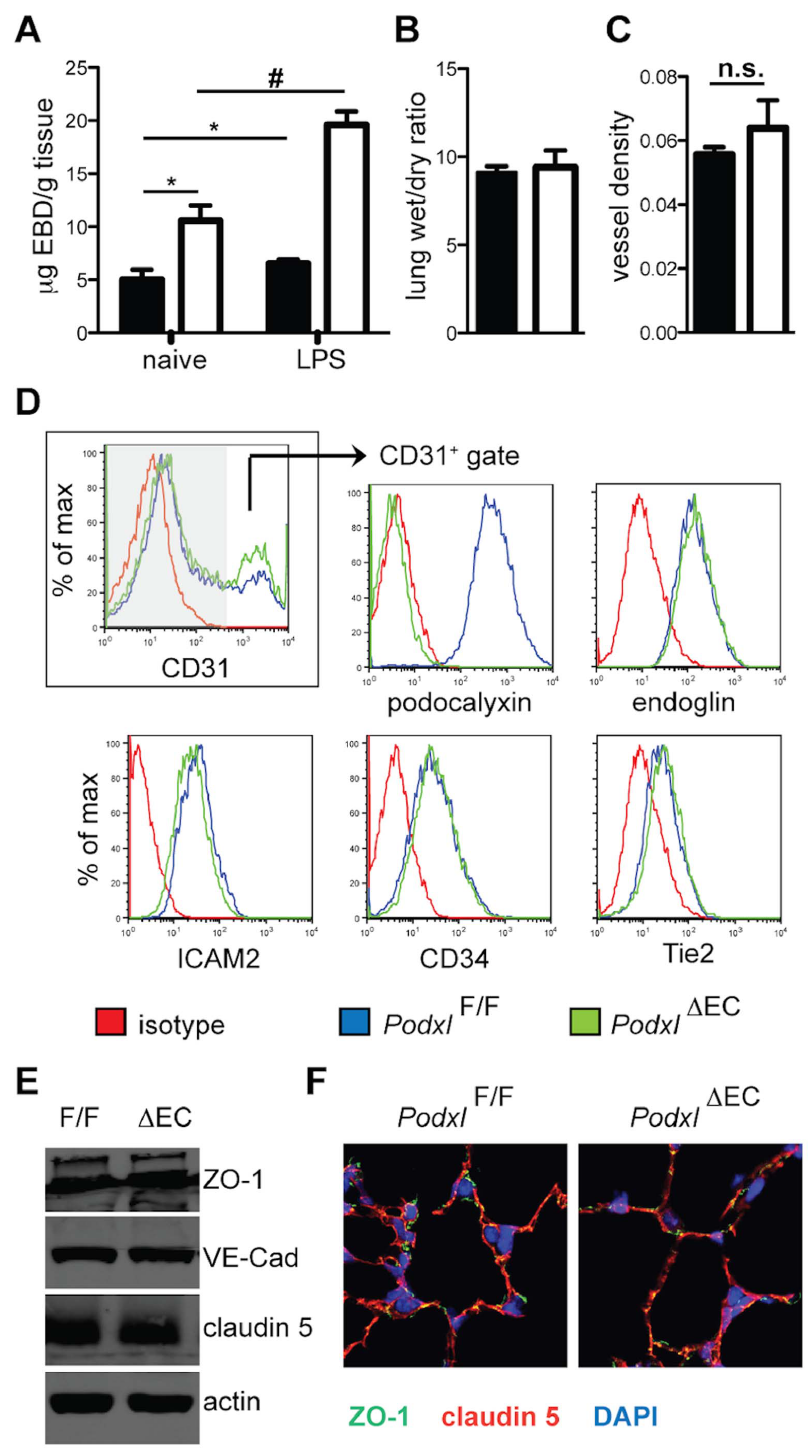
Figure 6. Podocalyxin deletion results in increased vascular permeability without altered endothelial cell frequency or immunophenotype. ( A ) Vascular permeability in lungs assessed by a modified Miles assay. Female mice were treated with PBS (naı¨ve) or LPS (2 mg/kg) intra-tracheally 24 h before sacrifice Podxl F/F (black bars), and Podxl D EC (white bars) (n=5–7 mice per genotype). One hour before sacrifice, mice received 20 mg/kg Evan’s blue dye via the lateral tail vein. *Significantly different with P , 0.05 by when compared to Podxl F/F naı¨ve mice. # Significantly different (P , 0.05) than LPS treated Podxl F/F mice by one-way ANOVA. ( B ) Lung edema presented as a ratio of wet/dry lung weight. Lungs were excised and weighed immediately for wet weight and subsequently dried at 60 u C for 36 h and weighed again to determine the dry weight (n=6 mice). ( C ) Vessel density was determined by the ratio of von Willebrand factor-positive (vWF + ) staining to total lung tissue. Data represent 4 images per mouse and 6 mice per group. ( D ) Lung tissue displays normal expression of endothelial cell markers by flow cytometry. Shown are representative flow cytometry histograms. The frequency of CD31 + endothelial cells from each genotype is shown in the first profile. All